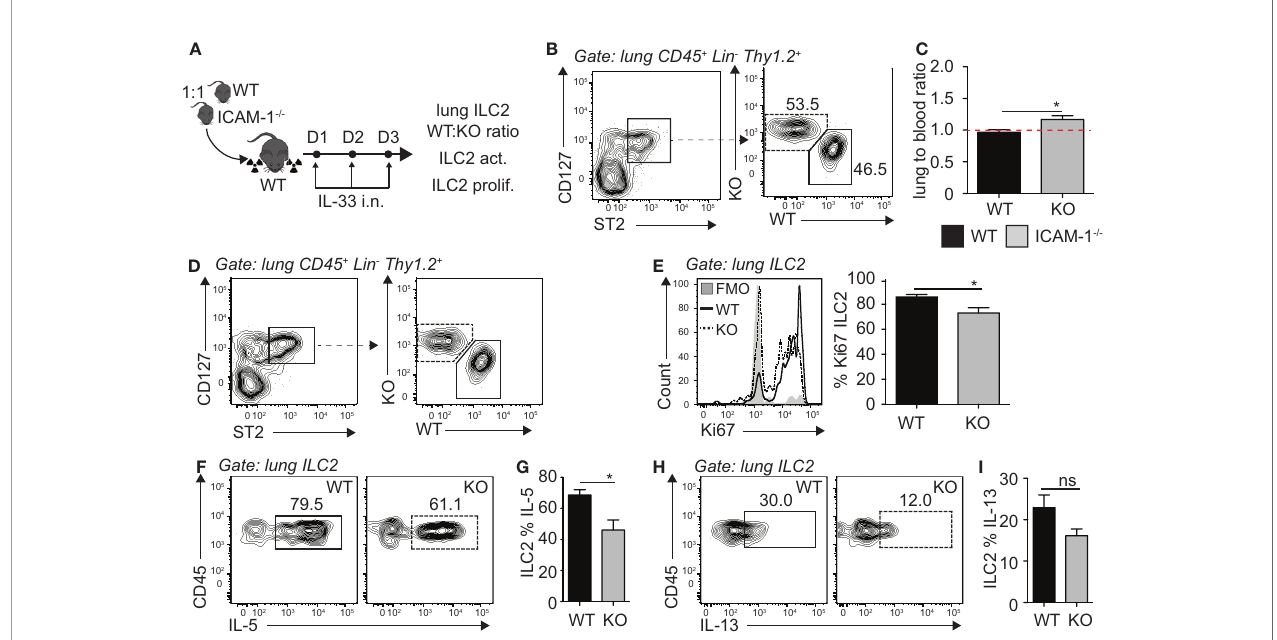
FIGURE 5 | ICAM-1 on ILC2s is not required for ILC2 accumulation in the lungs. (A) 5 × 10 6 1:1 mix of WT (CD45.1): ICAM-1 − / − (CD45.2) bone marrow cells were intravenously injected through the tail-vein to lethally irradiated WT (CD45.1) host mice. 4 weeks after transfer, mice were challenged intranasally on days 1-3 with 0.5 µg rmIL-33. On day 4, lungs were recovered, processed to single cell suspensions and analyzed for the presence of pulmonary ILC2s (CD45 + Lin − Thy1.2 + ST2 + CD127 + ). We further measured the expression of CD45.1 (WT) or CD45.2 (ICAM -1 − / − ) within total lung ILC2s by fl ow cytometry (B, C) , as well as the expression of Ki67 as a measure of proliferation (D, E) and intracellular IL-5 and IL-13 as a measure of activation (F – I) by fl ow cytometry in both CD45.1 (WT) and CD45.2 (ICAM-1 − / − ) pulmonary ILC2s. (B) Representative fl ow cytometry plots of total lung ILC2s expressing either CD45.1 (WT) or CD45.2 (ICAM -1 − / − ) and (C) corresponding quantitation presented as the ratio of CD45.1 (WT) and CD45.2 (ICAM -1 − / − ) ILC2s within total lung ILC2s, normalized to the peripheral blood CD45.1:CD45.2 ratio of each individual mice ± SEM. Red dotted line represents the ratio of 1. (D) Representative fl ow cytometry plots of CD45.1 + (WT) and CD45.2 + (ICAM-1 − / − ) expression within total lung ILC2s. (E) Representative fl ow cytometry plots depicting the frequency of Ki67 expression within CD45.1 + and CD45.2 + lung ILC2 populations and corresponding quantitation presented as mean frequency of Ki67 expression within CD45.1 + and CD45.2 + lung ILC2s ± SEM. (F-I) After processing to single cell suspension, lung cells were further stimulated with PMA, ionomycin and Brefeldin A for 4 h at 37°C prior staining for intracellular cytokine markers. Representative fl ow cytometry plots of IL-5 (F) and IL-13 (H) expression within CD45.1 + and CD45.2 + lung ILC2 populations and corresponding quantitation (G, I) presented as mean frequency of cytokine expression within CD45.1 + and CD45.2 + lung ILC2s ± SEM. Data are representative of 3 individual experiments with n = 5. *p < 0.05, ns, non-signi fi